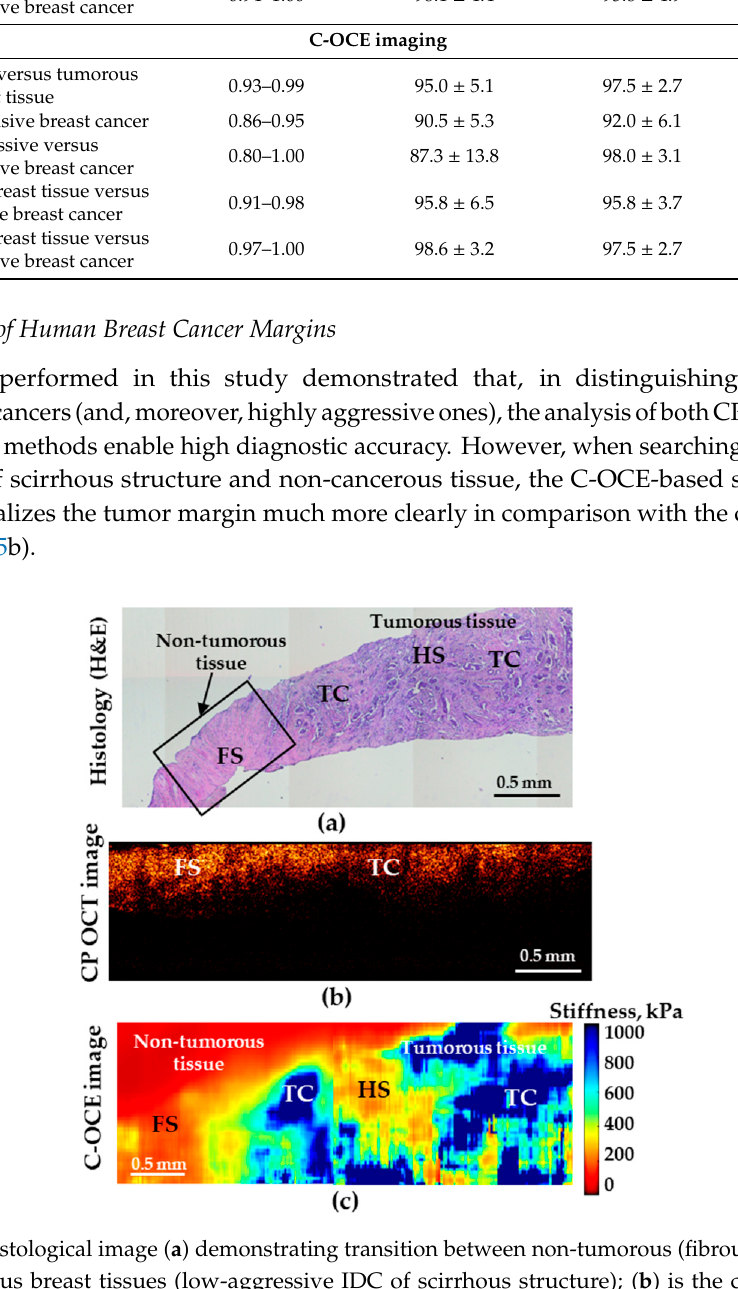
Figure 5. Histological image ( a ) demonstrating transition between non-tumorous (fibrous stroma—FS) and tumorous breast tissues (low-aggressive IDC of scirrhous structure); ( b ) is the corresponding CP-OCT image in the cross-polarization channel and ( c ) is the C-OCE images of the same area. HS denotes hyalinized stroma, and TC—clusters of tumor